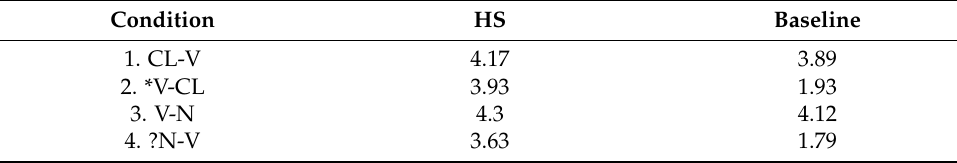
Table 5. Means of heritage and baseline ratings of clitics and NPs.